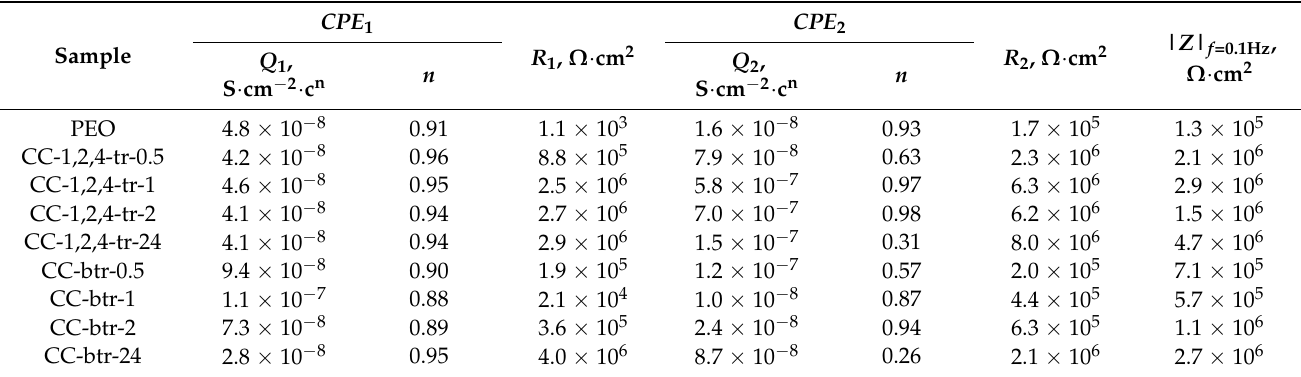
Table 3. Calculated parameters of EEC elements for samples of AlMg3 aluminum alloy with various types of CC and PEO-layer.